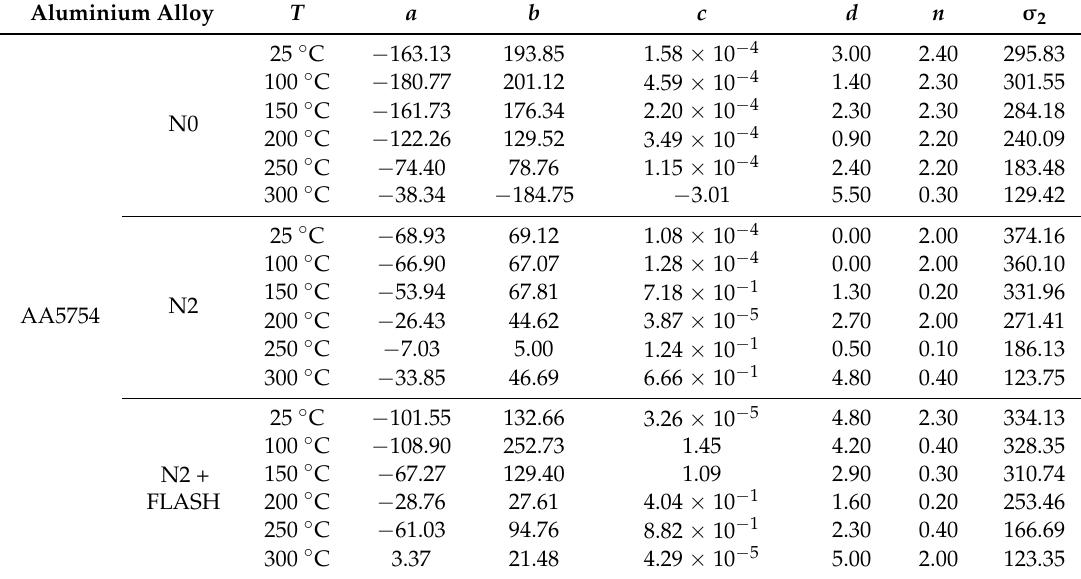
Table 3. Values of the parameters for the new flow rule proposed for